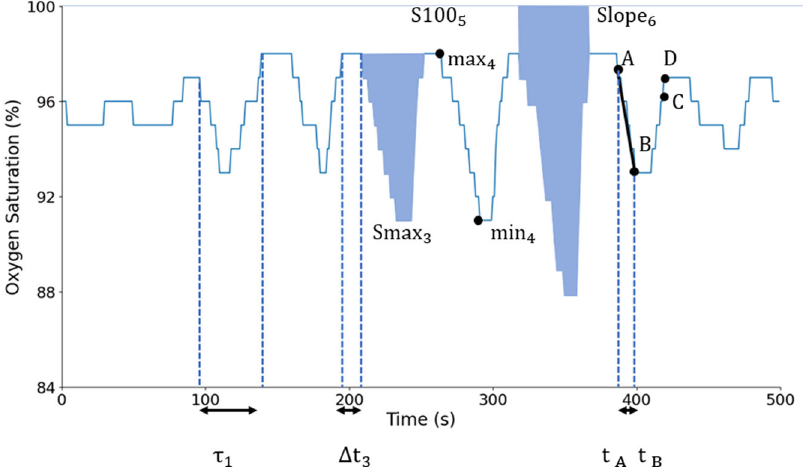
Fig. 7 Desaturation biomarkers. A, B, C, and D are the fi ducials points delimiting a desaturation